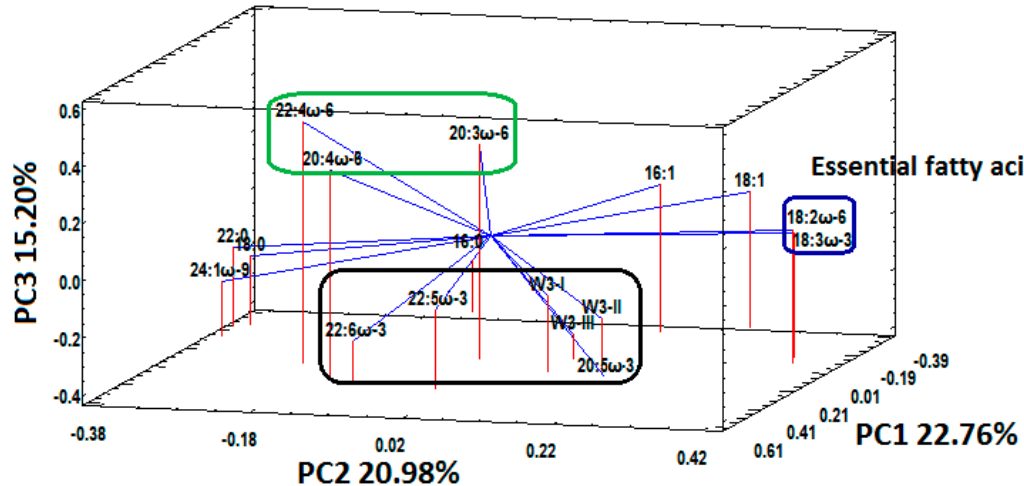
Figure 4. Principal components 1, 2 and 3 (PC1, PC2 and PC3, respectively) to study the correlation between selected fatty acids in maternal red blood cells and electronic food frequency questionnaire (e-FFQ) variables (WI = seafood as dinner, WII = seafood as spread or snack, WIII = ω -3 supplements) as . There is an association between 20:5 ω -3 (EPA), 22:5 ω -3 (DPA), 22:6 ω -3 (DHA) and WI, WII, WIII (black frame), while their ω -6 counterparts (green frame) and essential fatty acids (blue frame) do not correlate with the e-FFQ variables.